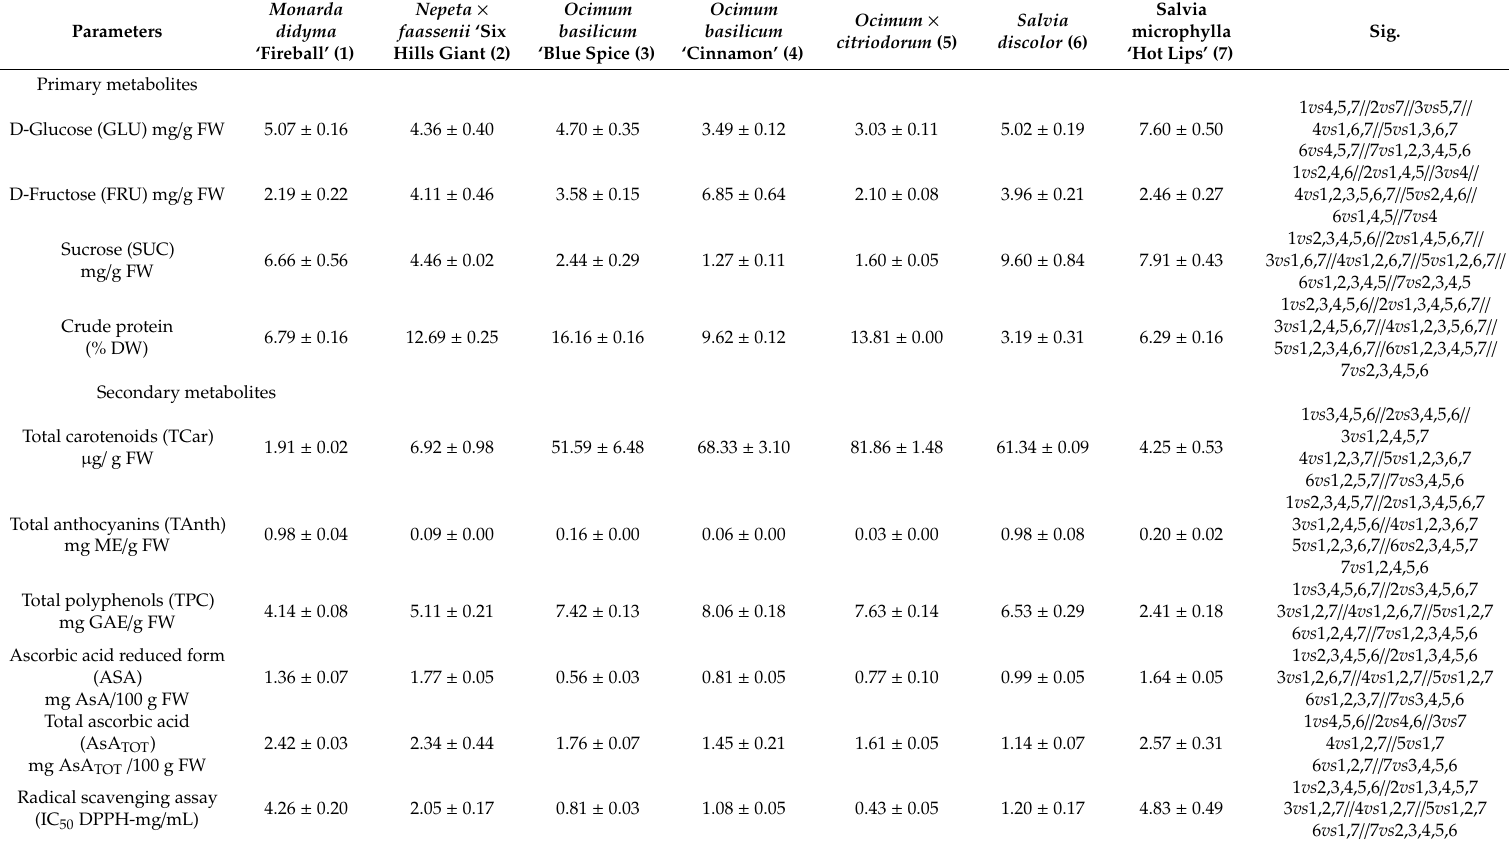
Table 2. Determination of primary and secondary metabolites in the seven studied flowers of Lamiaceae family. Data are presented as means ± standard error (SE, n = 3). Abbreviations: FW = fresh weight; DW = dry weight; GAE—gallic acid equivalents; CE— ± catechin equivalents; ME—malvin equivalents; sig. = significant post hoc test at p <